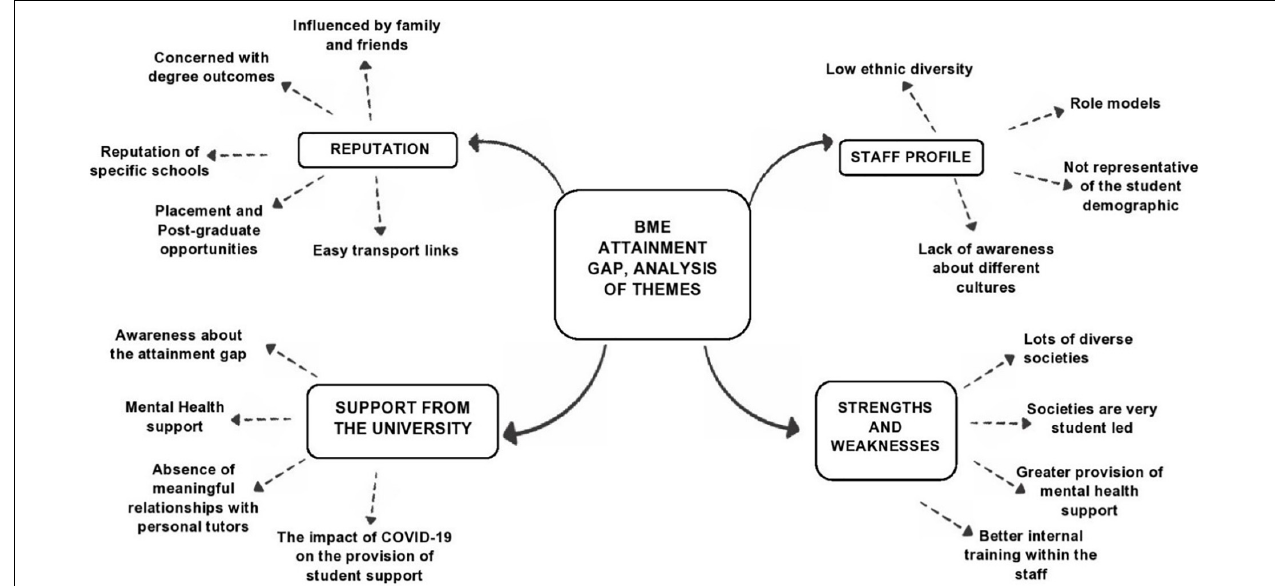
FIGURE 1 | A model showing the themes emerging from student views during focus